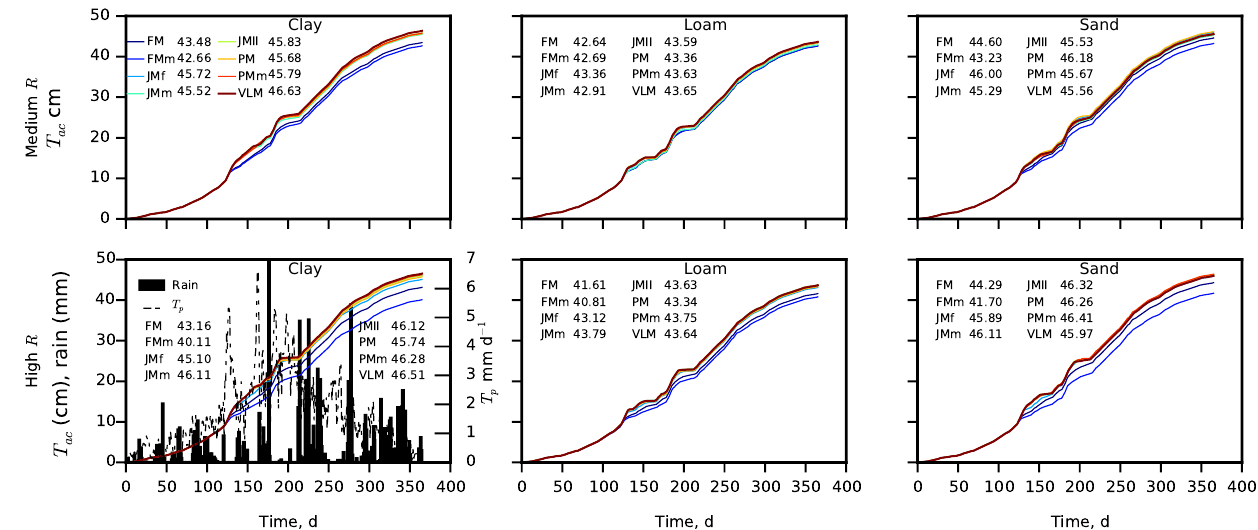
Figure 12. Time course of actual cumulative plant transpiration T ac predicted by the De Jong van Lier et al. (2013) model and empirical models for three soils (clay, loam, and sand) and two levels of root length density (medium and high), together with rainfall and potential transpiration T p for the growing season experiment. The total T ac values predicted by each model for the whole period are shown in the plot aside the model